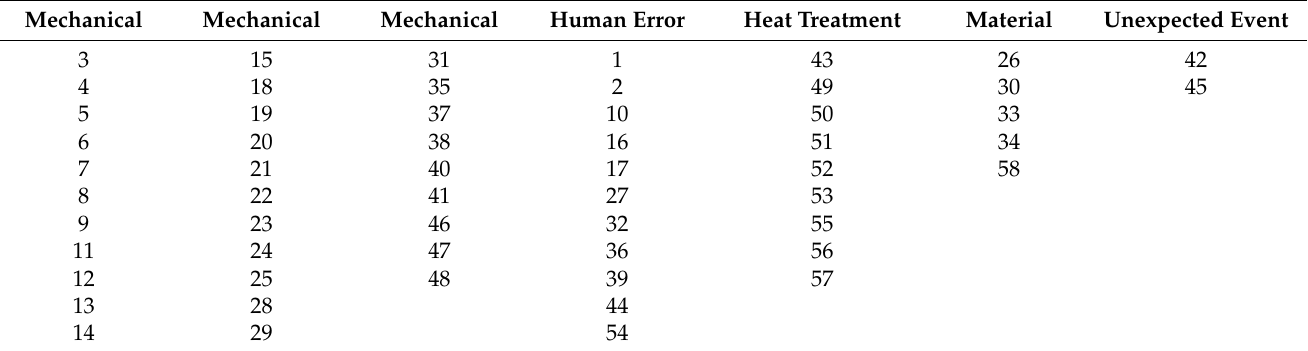
Table 5. Classification of kinds of failure by